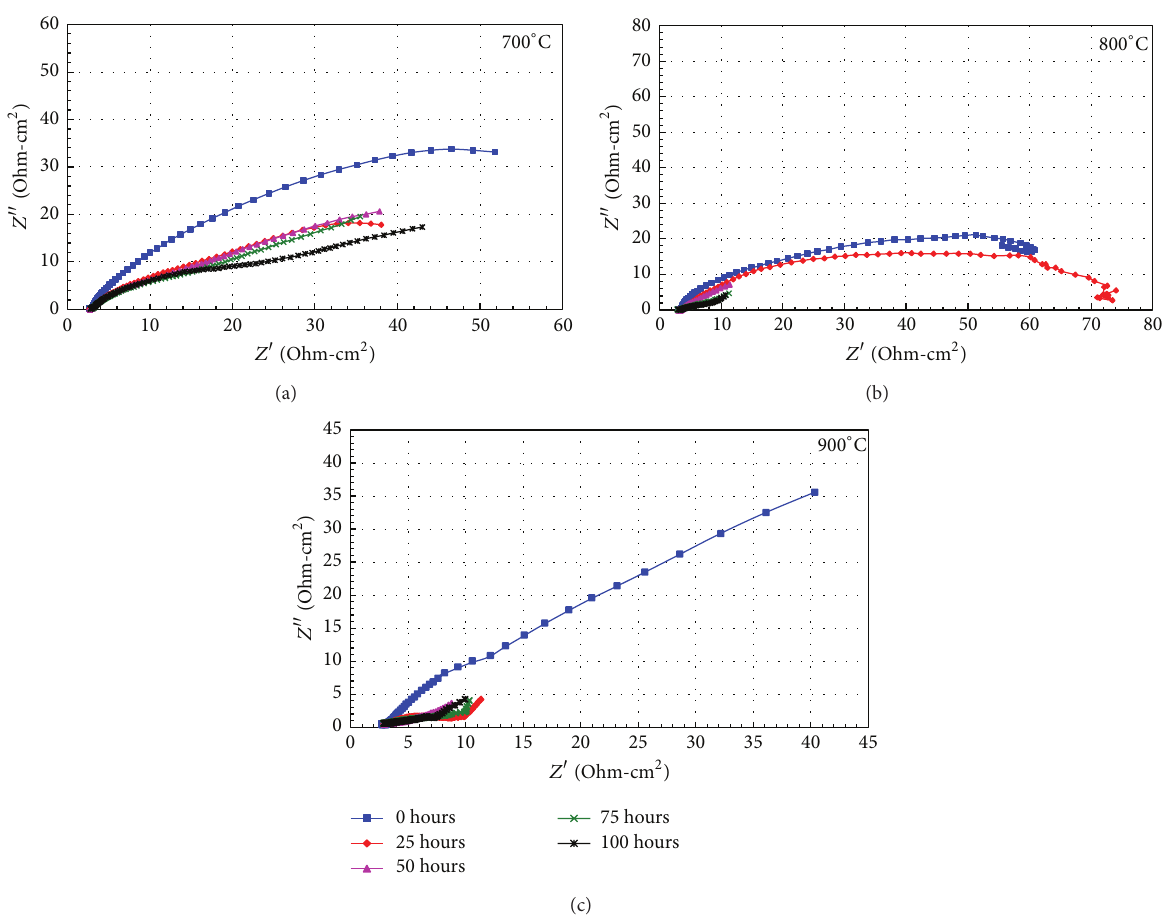
Figure 4: Progress of Nyquist plots of EIS response of Inconel 600 in NaCl-KCl at different temperatures: (a) 700 ∘ C, (b) 800 ∘ C, and (c) 900 ∘